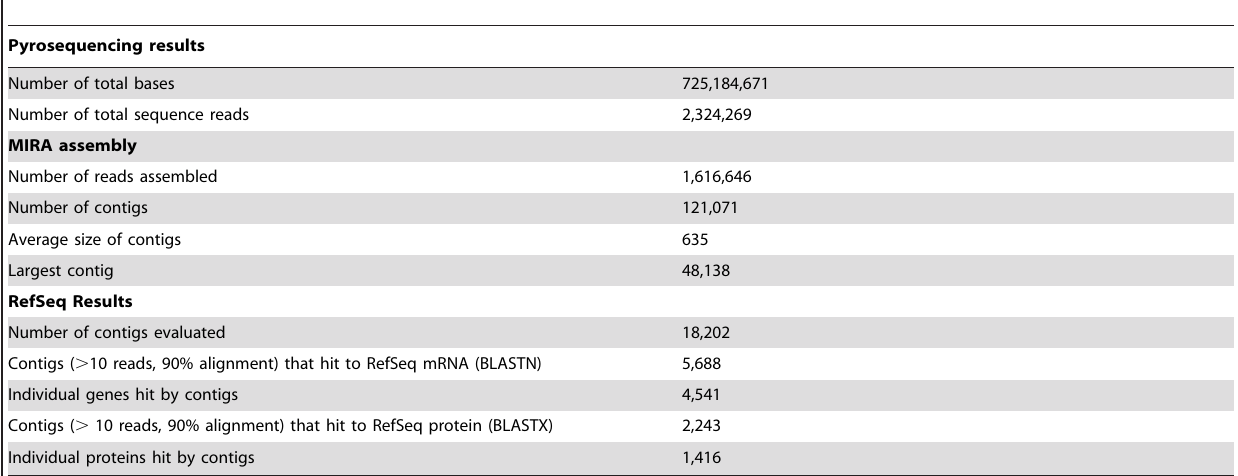
Table 1. Results for pyrosequencing, MIRA assembly, and comparison to RefSeq mRNA and protein